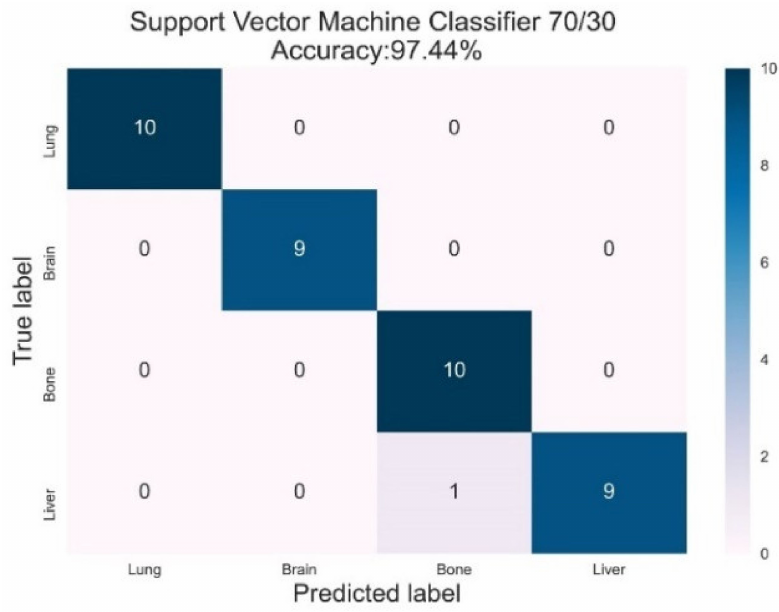
Figure 25. Confusion Matrix (Support Vector Machines Classifier). The classification report for the SVM classifier visualized in Figure 26 revealed the ex- cellent performance of the classifier. Precision and recall for all classes are ≥ 0.99 → ≤ 1.0 and thus has a very high F1 score for each class.